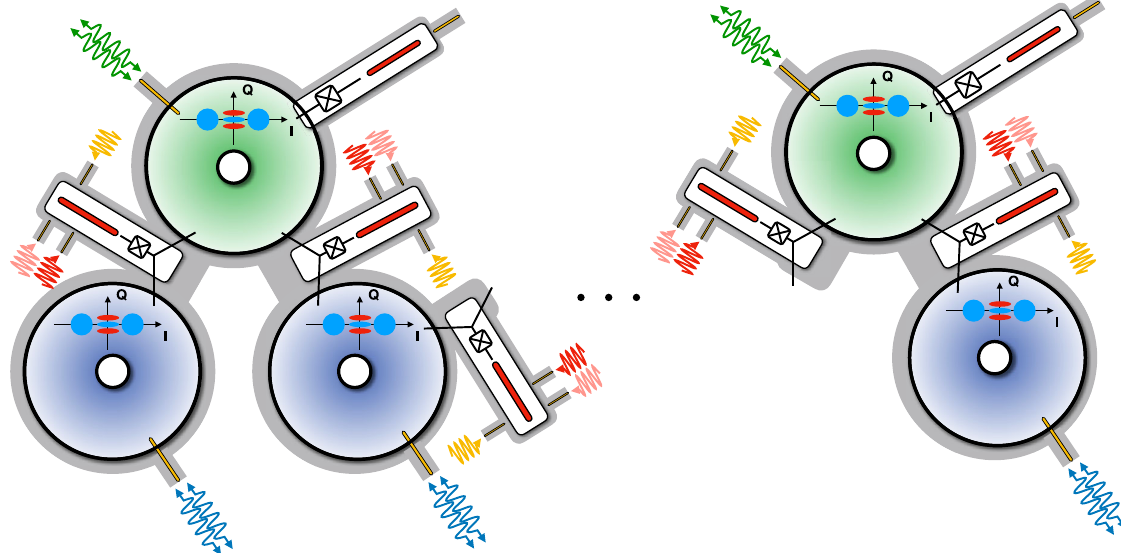
FIG. 2. Layout of a repetition cat qubit using high- Q 3D cylindrical postcavities [40]. Each data cat qubit (in blue cavities) is connected to a pair of ancilla cat qubits (in green cavities) for the joint-parity measurement. The results of the parity measurement are read out using the low- Q strip-line resonators (in red) coupled to green cavities. Each cat qubit is continuously driven via the two-photon driven-dissipative scheme (arrows). The couplings between cavity modes are mediated by a Josephson circuit and extra microwave drives, required for bias-preserving CNOT operations as detailed in Sec. IVand Fig. 11. The choice of cylindrical postcavities is to ensure high-quality factors, but a similar layout could be thought of in a 2D